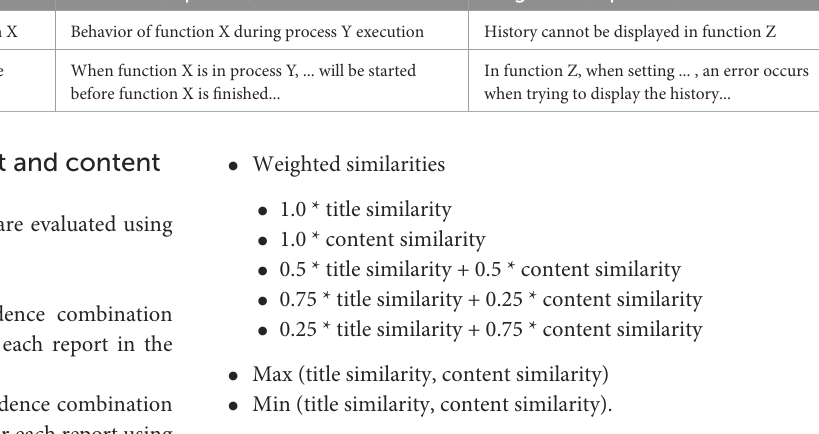
TABLE 1 Example of a triplet. Anchor (report A) Abnormal operation due to operation of function X Behavior of function X during process Y execution